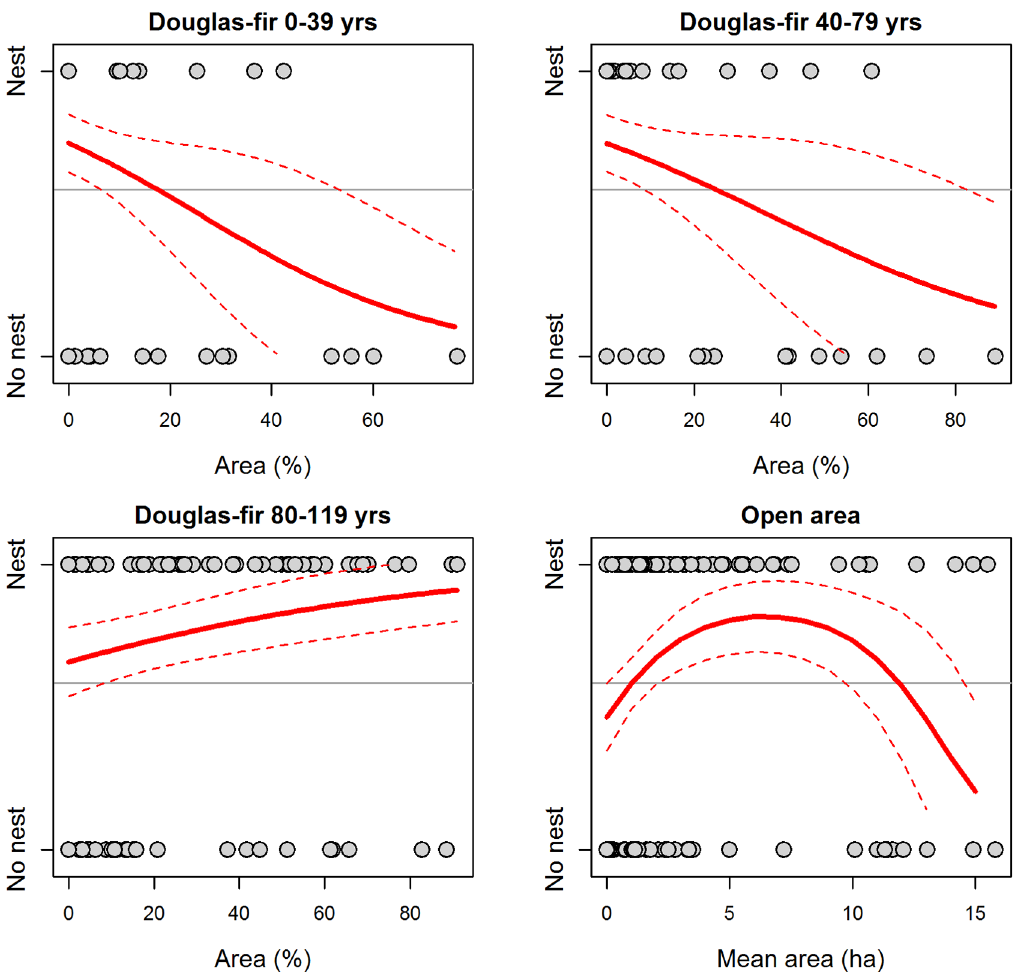
Fig 3. Predicted relationships between probability of nest occurrence and four forest habitat variables included in the GIS225 model (originally 25 variables considered) for the Okanagan-East Kootenay Region of the Williamson ’ s sapsucker Area of Occupancy in British Columbia, 2006 – 2008. Variables were calculated from geographic information system (GIS) habitat variables within a 225 m radius of the nest or random point. Grey points depict nest occurrence ( ‘ Nest ’ ) or a random point ( ‘ No nest ’ ), and the title of each plot indicates the habitat variable. Solid lines indicate predicted values and thin dashed lines represent the 95% prediction interval. Horizontal line depicts proportion of points that were nests (i.e., the baseline probability of response variable having a value of